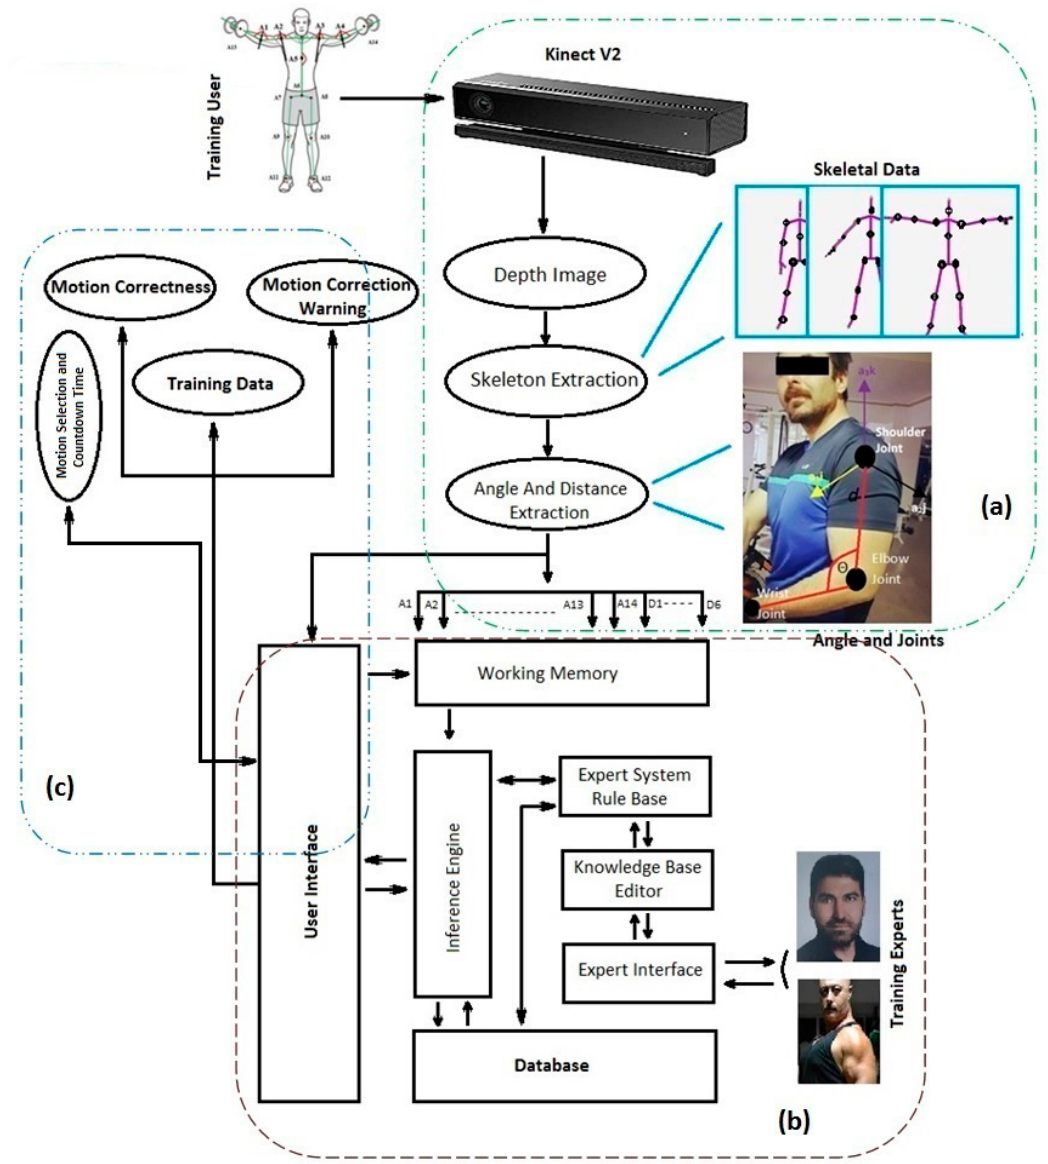
Figure 4. System architecture: ( a ) obtaining training data; ( b ) expert system structure; ( c ) giving feedback to users.